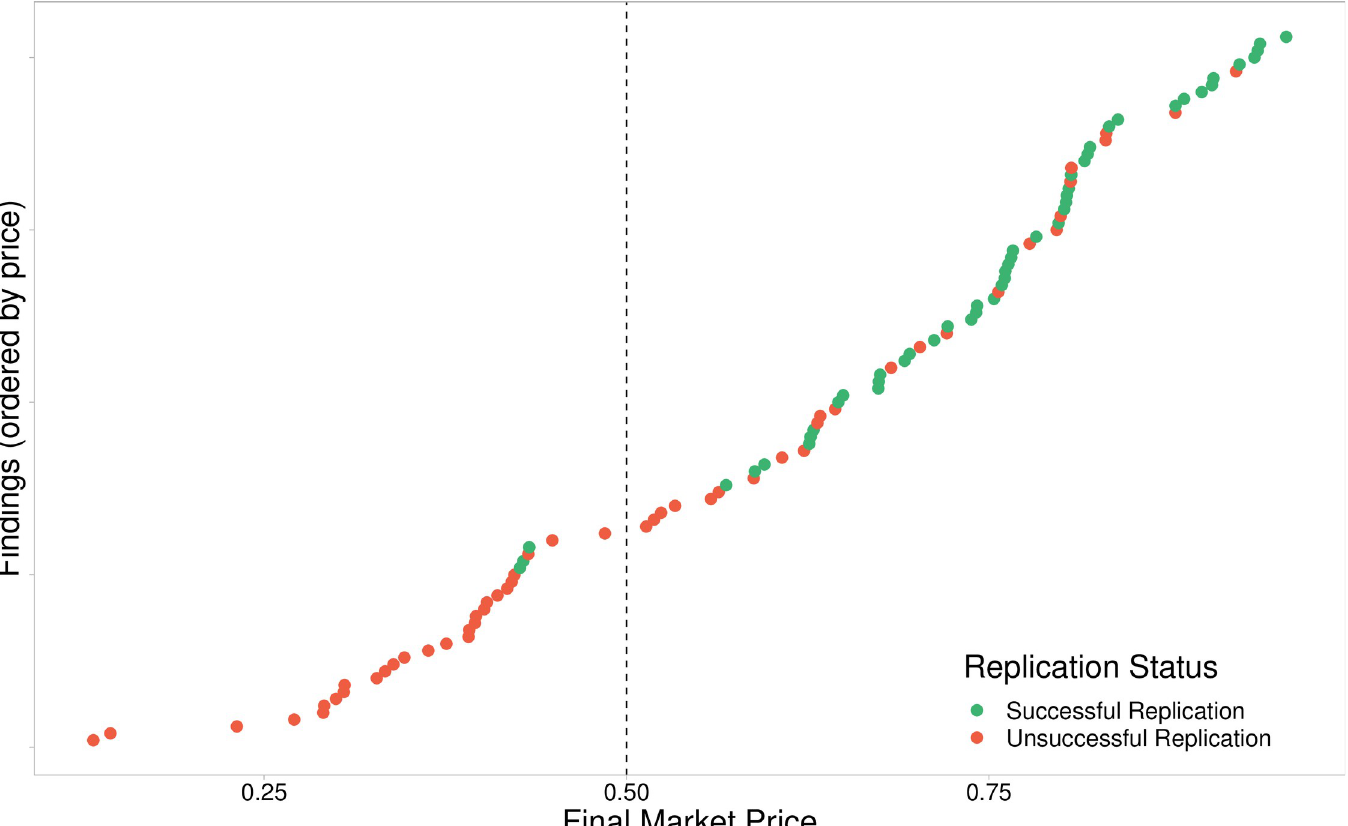
Fig 1. Market beliefs. This figure plots the final prices of the 103 markets included within this dataset ordered by price. The green dots represent successful replications, and the non-replications are represented by the red dots. The horizontal line at 0.5 indicates the binary cut off used to determine the markets aggregated prediction.